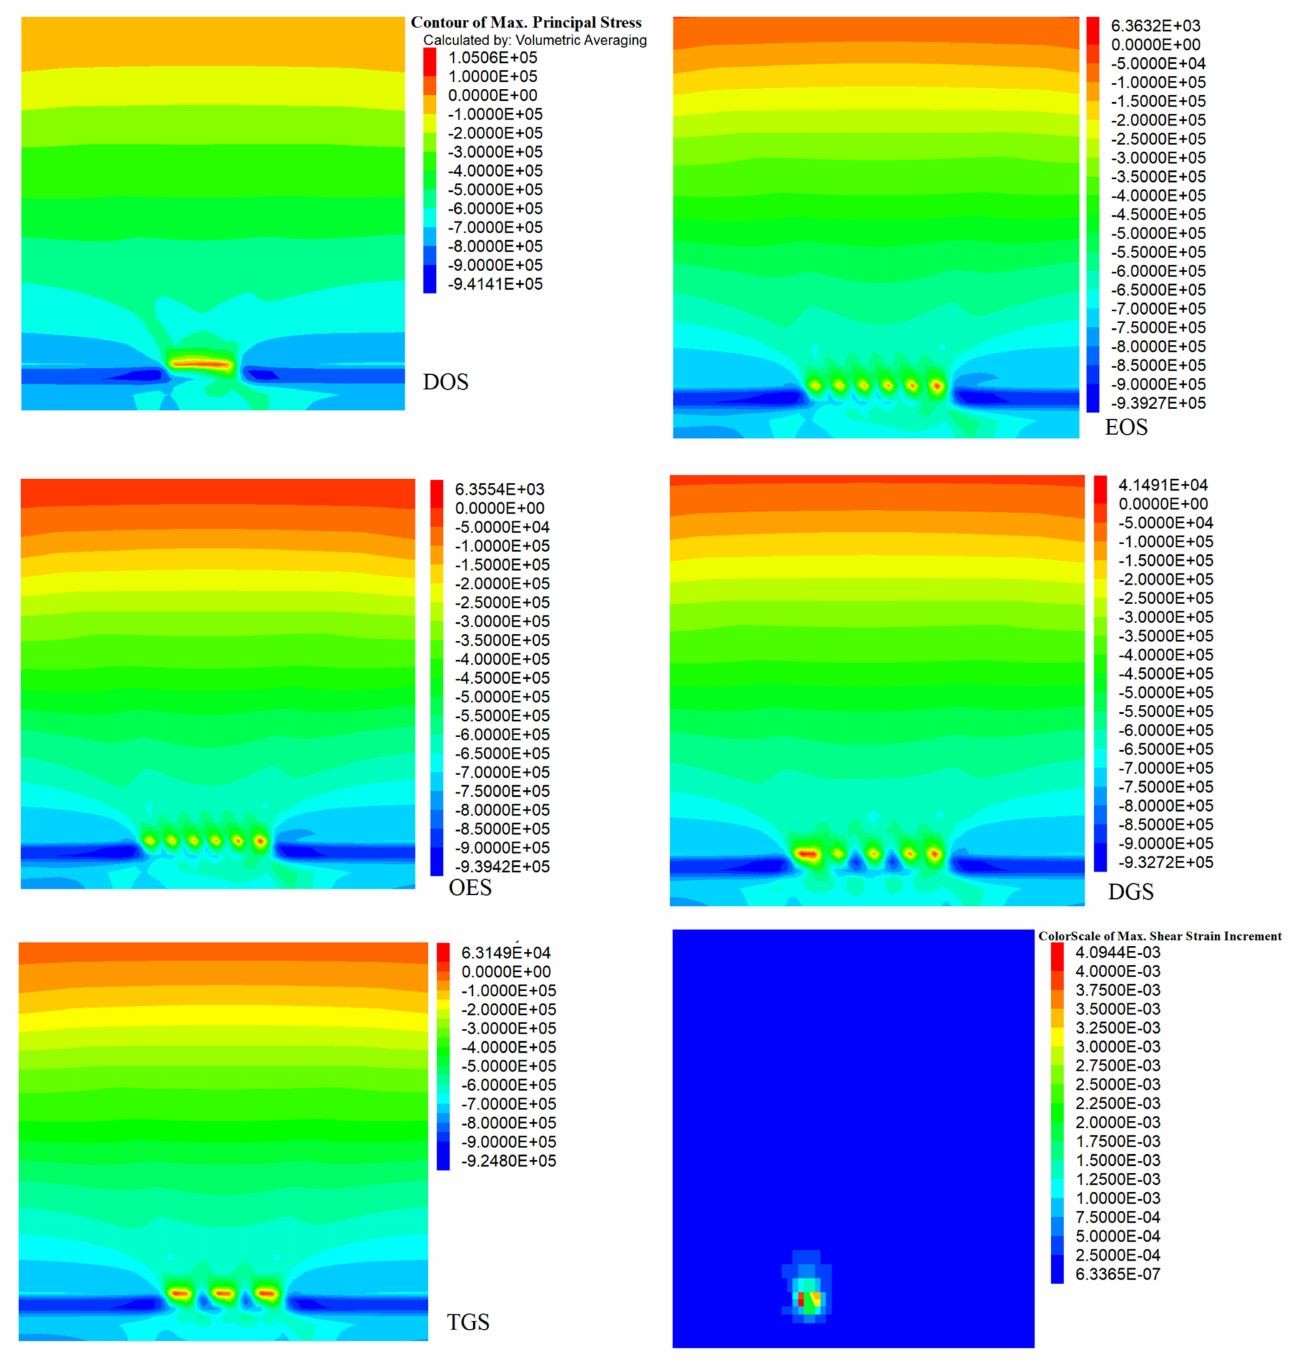
Figure 9. Contours of maximum principal stresses. However, during the second excavation cycle, excavating the last six coal slices in a given panel, the displacements across the models decrease, indicating that the backfill bod- ies became active in supporting the overlying load. These displacement values converge towards the ninth coal slice excavation across the five models (Figure 12c). Ground dis- placements across the models are reduced to nearly 25 mm when the panel’s last coal slice is excavated and backfilled (Figure 12d). Therefore, induced ground displacement